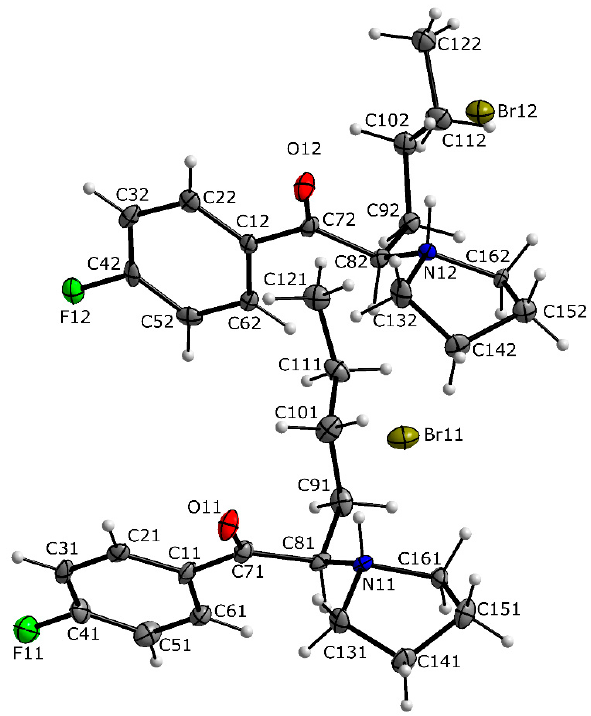
Figure 7. The molecular structure of 1-(4-fluorophenyl)-2-(pyrrolidin-1-yl)hexan-1-one hydrobromide ( 3 ), showing the atom-labelling scheme.